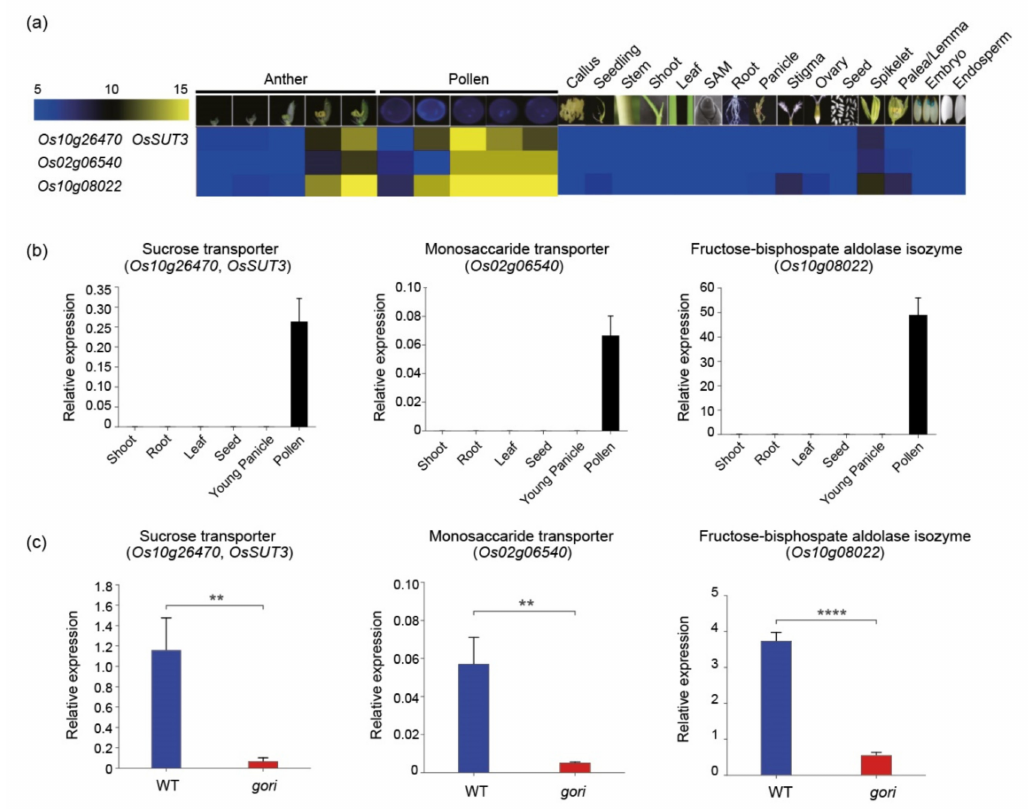
Figure 4. Validation of the dissected model and expression analysis of three carbohydrate metabolism-related genes in cluster H. ( a ) Heatmap analysis of three cluster H genes ( Os10g26740 , Os02g06540 , and Os10g08022 ). Numeric values indicate an average of the normalized log 2 intensity values. ( b ) Expression profiles of the three pollen-preferred genes based on qRT-PCR in various rice tissues: shoot, root, leaf, seed, young panicle, and pollen. ( c ) The expression of three pollen-preferred carbohydrate genes was significantly downregulated in the gori mutant compared to the wild-type plants. OsUbi5 ( Os01g22490 ) was used as an internal control. There were three biological replicates from the performed t -test on independent samples, with Bonferroni correction. ** 0.001 < p ≤ 0.01; **** p ≤